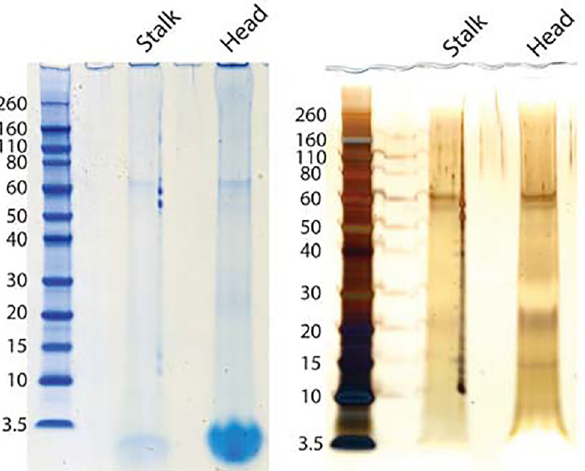
Fig 2. PAGE separation of stalk (S) and Head (H) skeleton matrix. The same gel was first stained with Coomassie Brilliant Blue (CBB, left) and then with silver (right). The molecular weight of marker proteins is given in